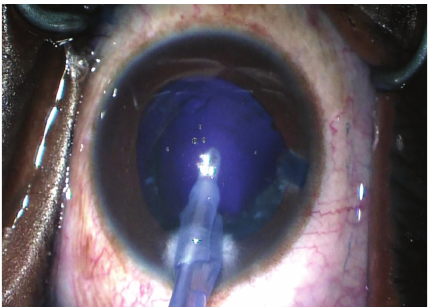
Figure 4: Photograph after cortex removal with irrigation and aspiration. Notice the absence of red reflex and the blue hue of the posterior